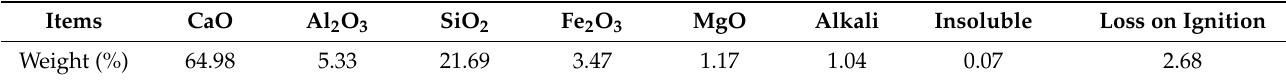
Table 1. Chemical composition of the cement.